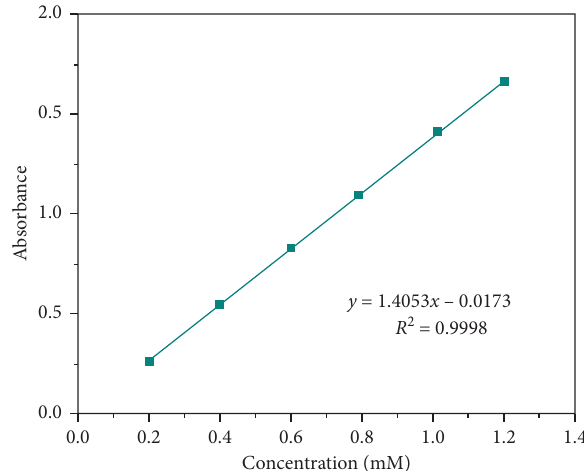
Figure 2: Calibration curve of amoxicillin obtained by UV-Vis absorbance at